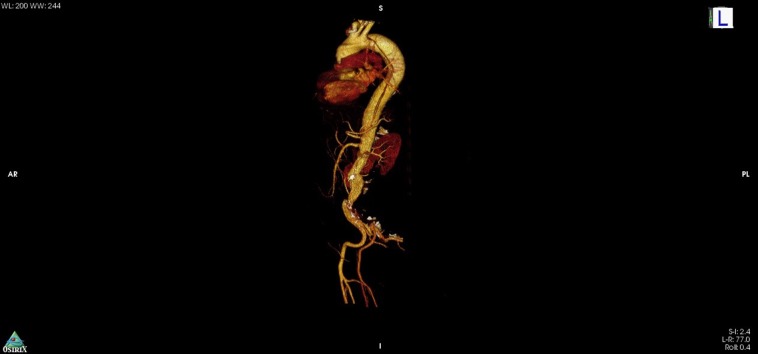
Computed tomography angiography at admission showing Stanford type B aortic dissection.